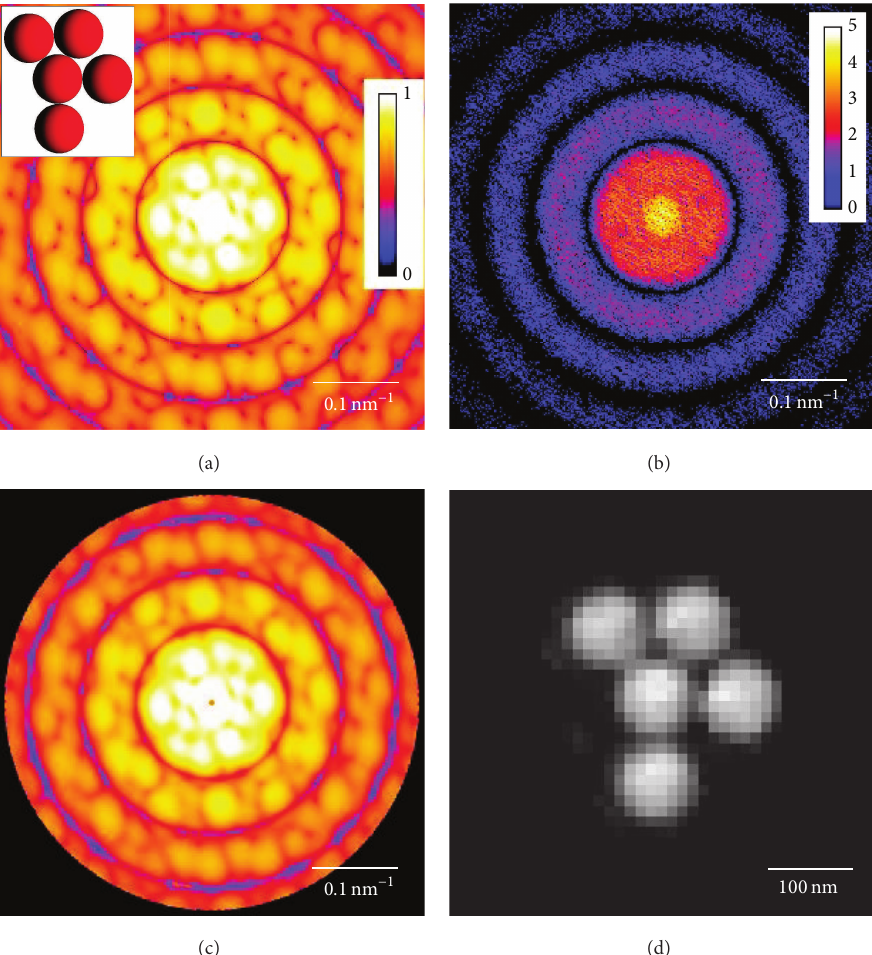
Figure 4: (a) Scattered intensity (logarithmic scale) calculated for a single asymmetric cluster (shown in the inset). (b) Coherently scattered intensity from a disordered system consisting of 𝑁 = 10 clusters in random position and orientation. Scattered signal corresponds to the incident fluence of 4⋅10 11 photons /𝜇 m 2 and contains Poisson noise. (c) Scattered intensity corresponding to an asymmetric cluster recovered from 𝑀 = 10 5 diffraction patterns of the form (b). (d) Structure of a single cluster reconstructed by an iterative phase retrieval algorithm using the diffraction pattern shown in (c). The intensities in (a), (c) are given in arbitrary units, and in (b) in photon